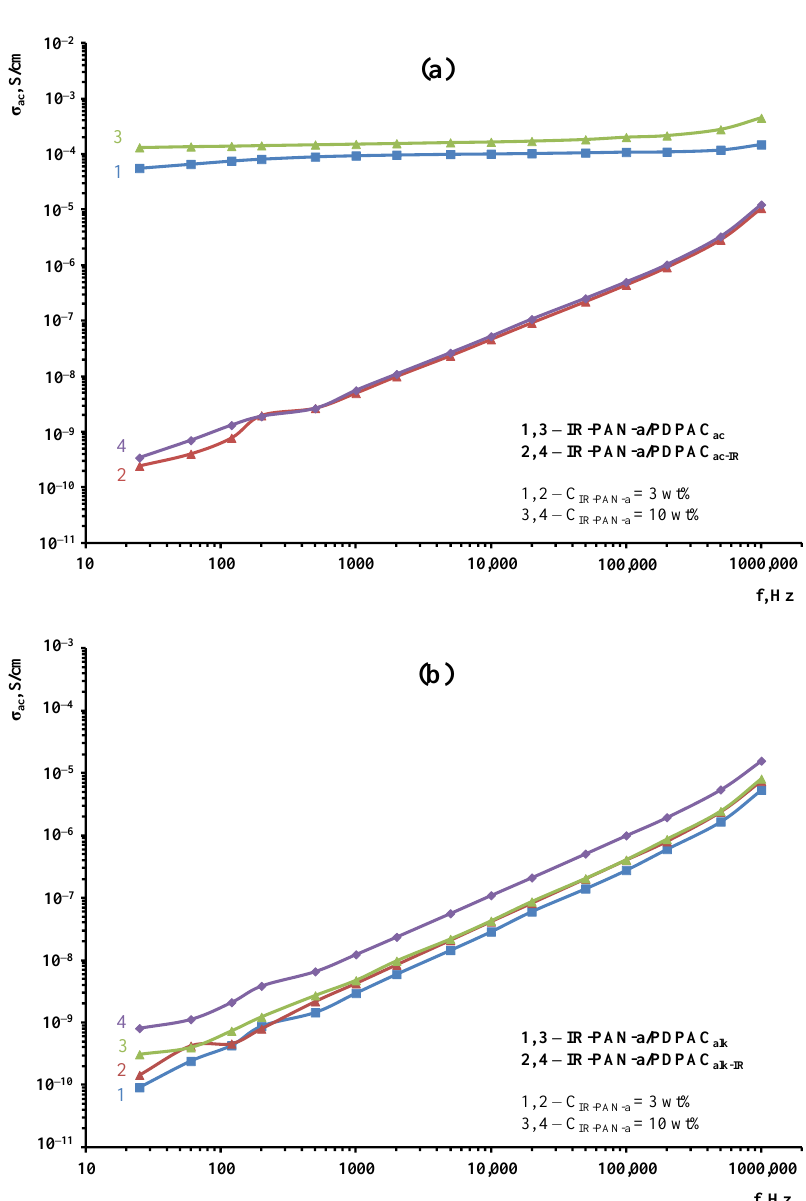
Figure 15. Frequency dependence on the conductivity for IR-PAN-a/PDPAC (1, 3) and IR-PAN-a/PDPAC IR (2, 4) prepared at C IR-PAN-a = 3 wt % (1, 2) and 10 wt % (3, 4) in an acidic ( a ) and an alkaline medium ( b ). Table 3. The conductivity values of materials.